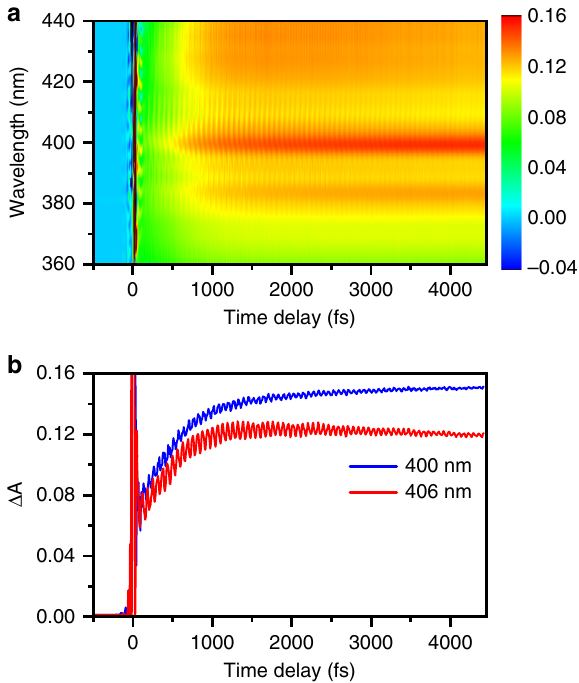
Fig. 3 Time-resolved differential absorption spectra. a Differential absorption spectra of photodetached phenoxide in aqueous solution as a function of pump-probe time delay. The color scale gives the Δ A value. b Time-traces at 400 nm (blue) and 406 nm (red), showing pronounced modulations due to vibrational wave packet dynamics. Source data